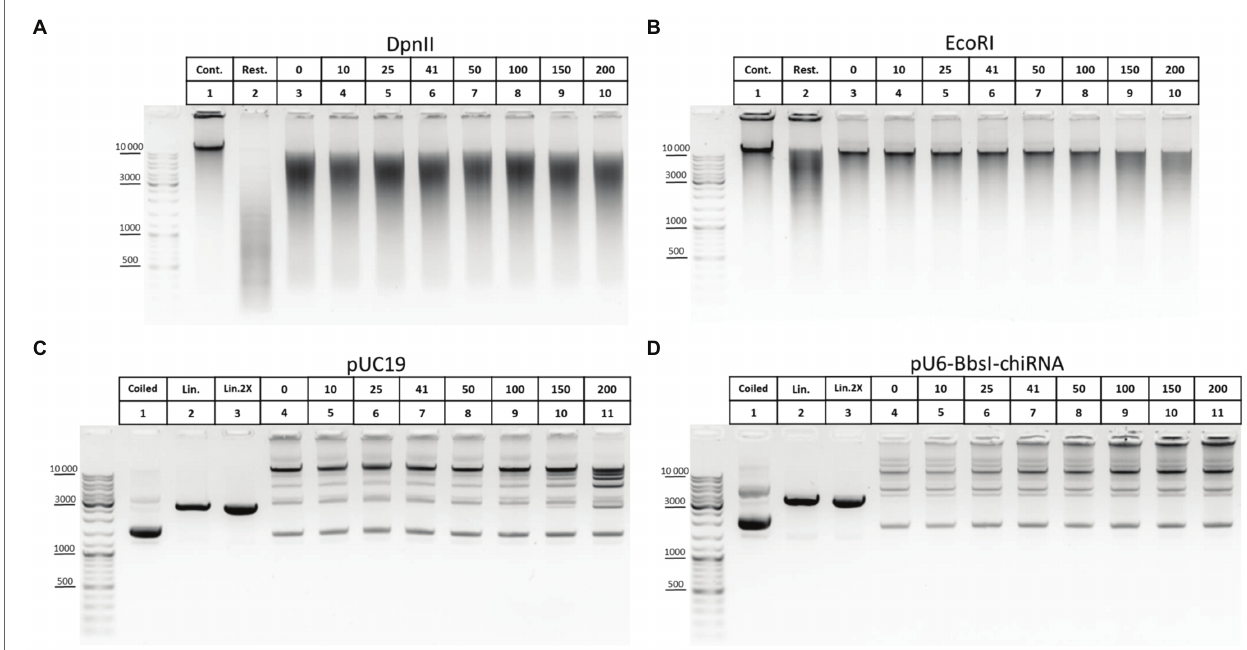
FIGURE 8 | Inhibition of T4 DNA ligase activity with NaCl. (A,B) The ability of T4 DNA ligase to ligate DNA in the presence of NaCl using genomic DNA. Genomic DNA was isolated, dissolved, treated with RNase I, purified on AMPure XP beads (lane 1), and digested with DpnII in DpnII buffer pH 6.0 (A) or with EcoRI in EcoRI buffer (B) as in Figure 5E . After digestion, REs were heat inactivated and DNA was purified on AMPure XP beads and subjected to electrophoresis (lane 2) or ligated in solution as in Figure 6E in the presence of different concentrations of NaCl (indicated by the upper raw of figures presented above the picture). Then, DNA was desalted by purification on AMPure XP magnetic beads and subjected to electrophoresis. Lane 1, non-digested DNA; lane 2, digested DNA; and lanes 3–10, DNA ligated at different concentrations of NaCl (0–200 mM). 41 mM is a concentration on NaCl in ligation reaction from Comet et al. (2011). One of the three replicate experiments is shown. (C,D) The ability of T4 DNA ligase to ligate DNA in the presence of NaCl using plasmid DNA. Plasmid DNA of pUC19 (C) or of pU6- BbsI-chiRNA (D) was linearised using a unique EcoRI site in the backbone. Restriction digestion was performed using 10 U of EcoRI in EcoRI buffer in a volume of 20 μ l. Then, RE was heat inactivated and DNA was precipitated and washed with ethanol as in Figures 2A – C , dissolved in 10 mM Tris-HCl pH 8.0, ligated in solution as in Figure 5E , and subjected to electrophoresis. Lane 1, non-digested plasmid (400 ng); lane 2, linearised plasmid (400 ng); lane 3, a double amount of linearised plasmid was taken after precipitation with ethanol; and lanes 4–11, DNA ligated in the presence of different concentrations of NaCl (0–200 mM). 41 mM is a concentration on NaCl in ligation reaction proposed from Comet et al. (2011). One of the three replicate experiments is